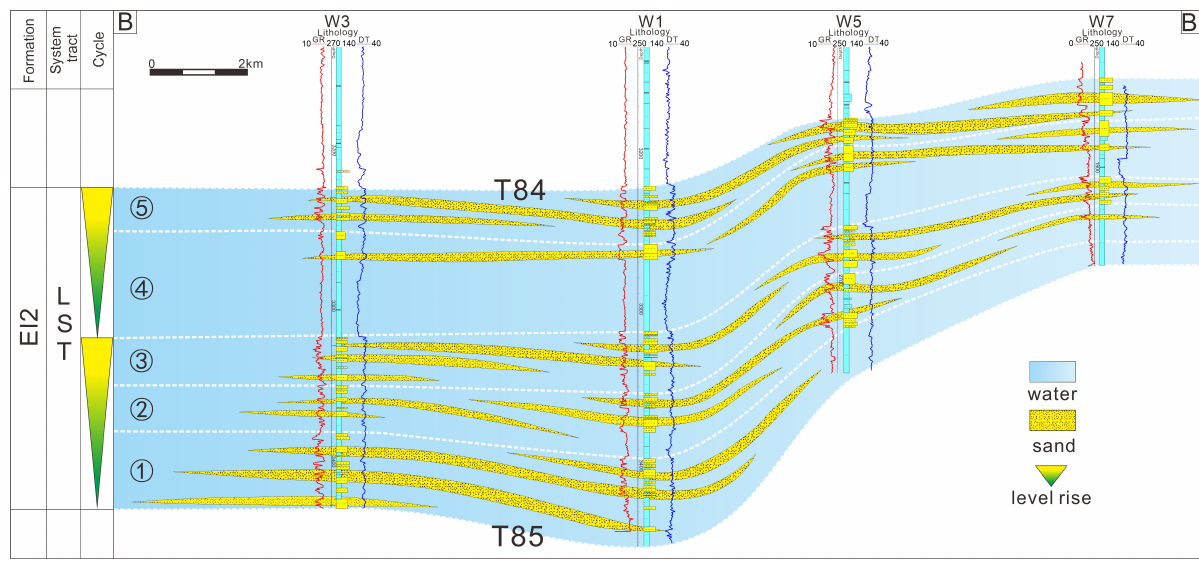
Figure 9. Sequence stratigraphic correlation section of beach-bar sand bodies of Mbr2 stage in the Weixinan sag. The five sand bodies in the LST show an obvious retrogradation upward. Sand thickness contour maps were constructed to depict the distribution regularity of the five stages of beach-bar sand bodies in the WZ12-2 area of the Weixinan sag (Figure